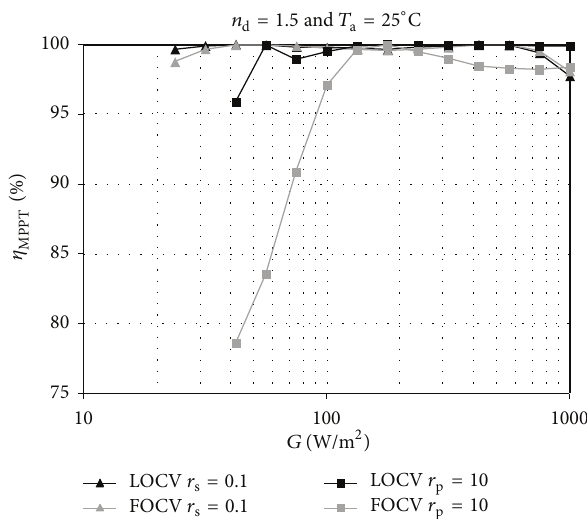
Figure 7: Computed 𝜂 LOCV methods for a single PV cell with 𝑇 = 0.1 (and 𝑟 for both 𝑟 s